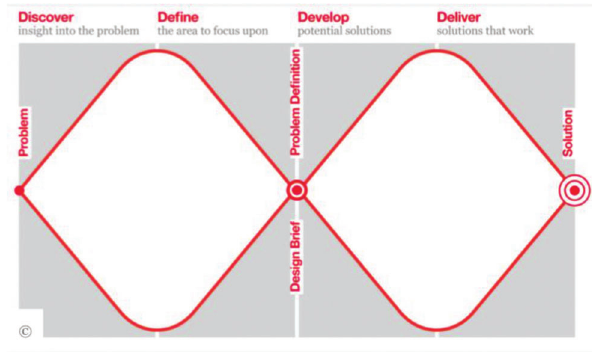
Figure 2 - Double Diamond diagram – a graphical way of describing Design Thinking. http://www.designcouncil.org.uk/news-opinion/ design-process-what-double-diamond